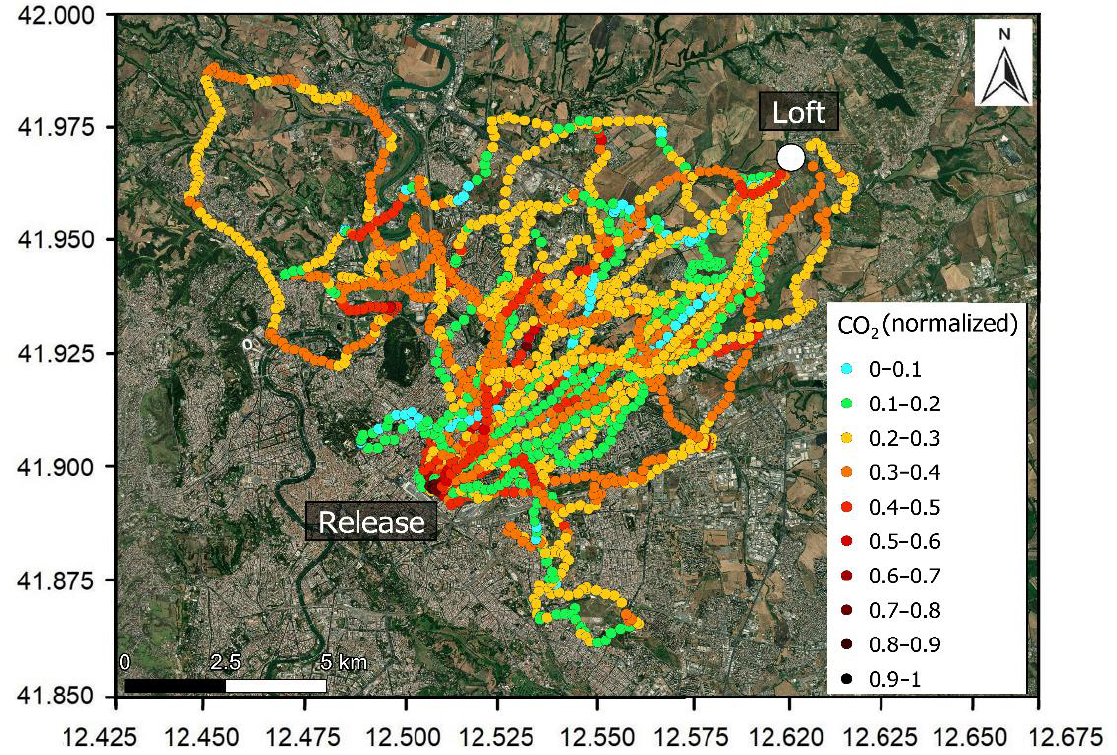
Figure 3. Map of data subsample used for the regression model (i.e., one GPS value every 15 s). The map shows the tracks of pigeons released on different days. The colour intensity depicts the CO 2 concentration measured after normalization to allow for better comparison between flights.